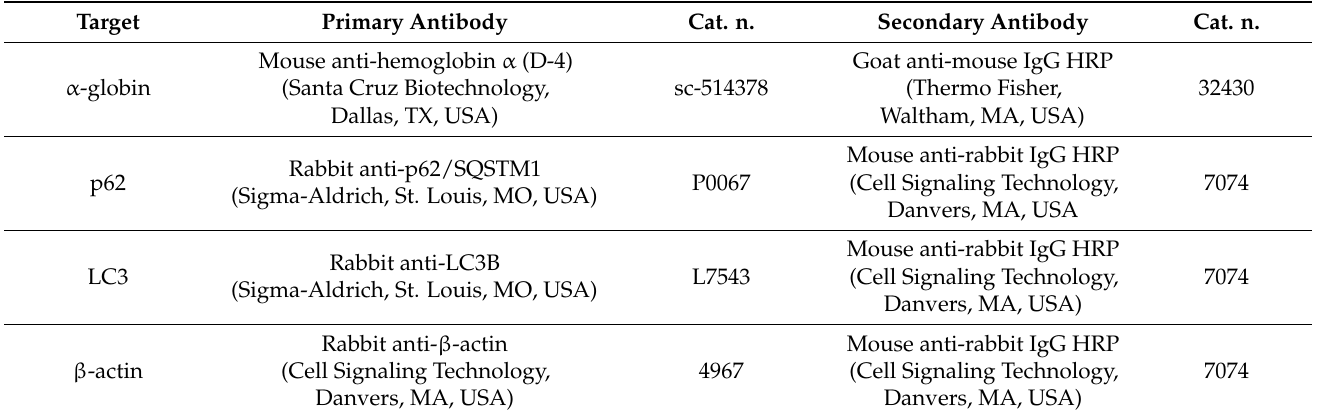
Table 2. Western blot primary and secondary antibodies employed for the detection of soluble α -globin chains and autophagy-related markers in cloned